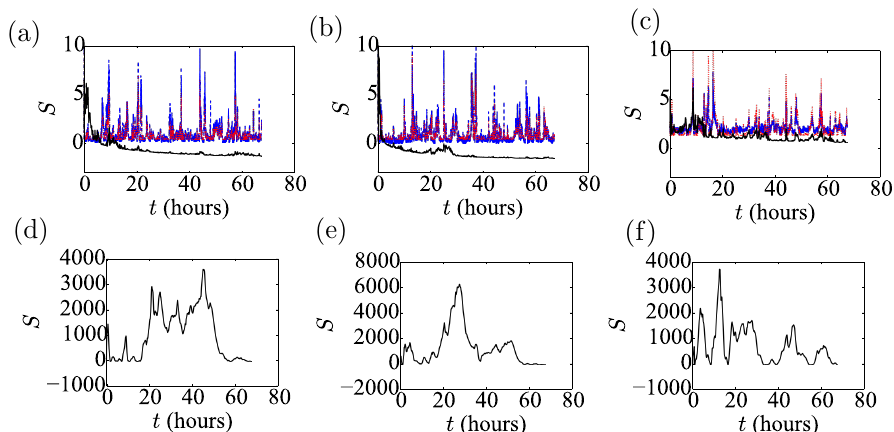
Figure 6. ( a – c ) Log scores, S , for latitude ( a ) longitude ( b ) and altitude ( c ) inferences from the Port Douglas data using the KF with the OU noise model. ( d – f ) The same as above, but for the KF with iid Gaussian noise model.